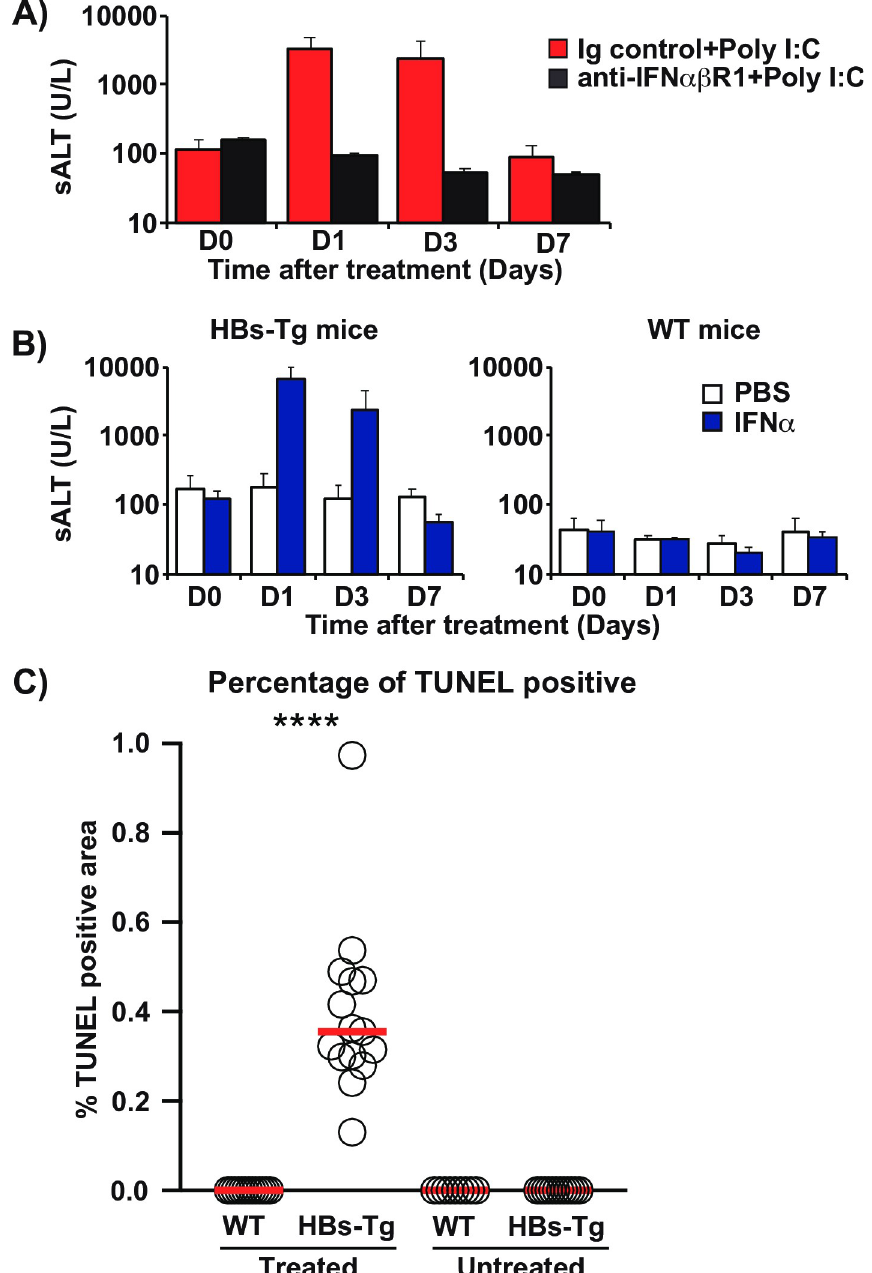
Fig 2. IFN-1s trigger HBsAg-associated liver injury in the absence of inflammatory cell infiltration. (A) Isotype control antibodies (250 μ g: red bars) or anti-IFN αβ R1 (250 μ g, black bars) were intraperitoneally injected into HBs-Tg mice (n = 3–4) 24 hours before poly I:C treatment. ALT levels on days 0, 1, 3, and 7 after poly I:C treatment are shown. (B) Serum ALT values in HBs-Tg (left graph) and WT mice (right graph) on days 0, 1, 3, and 7 after intravenous injection of PBS (white bars) or IFN α (5 million units (MU)/kg: blue bars). (C) The percentage of TUNEL positive area in WT and HBs-Tg mice after IFN α treatment ( ���� Dunn’s post hoc test, p <